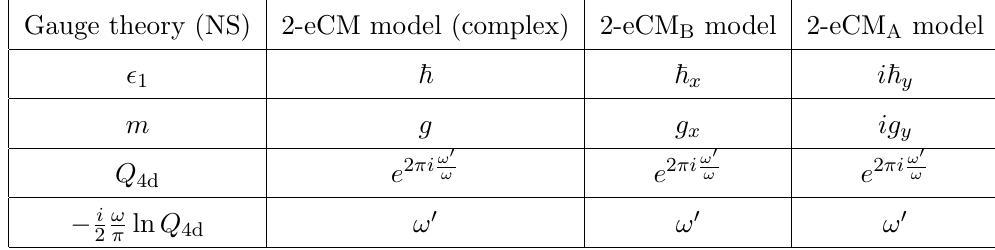
Table 1 . Map of 4d SU(2) N = 2 (cid:3) gauge theory and 2-eCM B , 2-eCM A